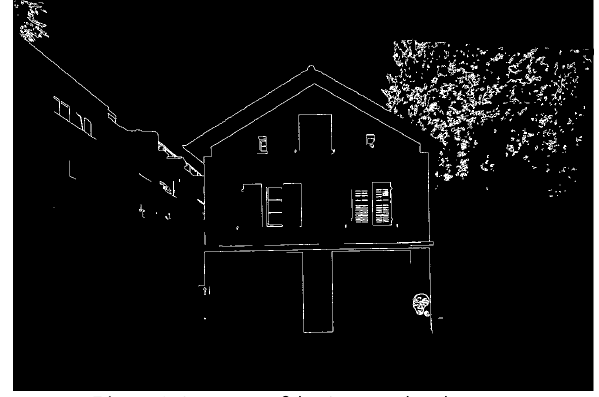
Figure 4. Outcome of the Canny edge detector.